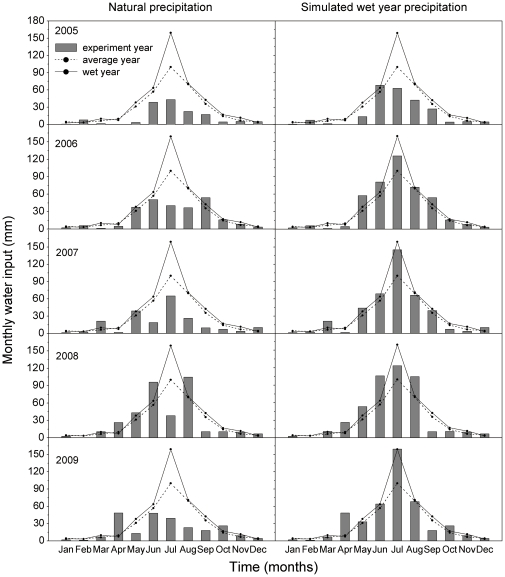
Monthly water input of long-term average and wet years and of individual experiment years 2005–2009.For the natural precipitation treatments (NP, left panel), the column represents precipitation only; for the simulated wet year precipitation treatments (SWP, right panel), the column represents precipitation plus irrigation. The solid and dotted line indicate long-term average and wet year precipitation during 1982–2003, respectively.